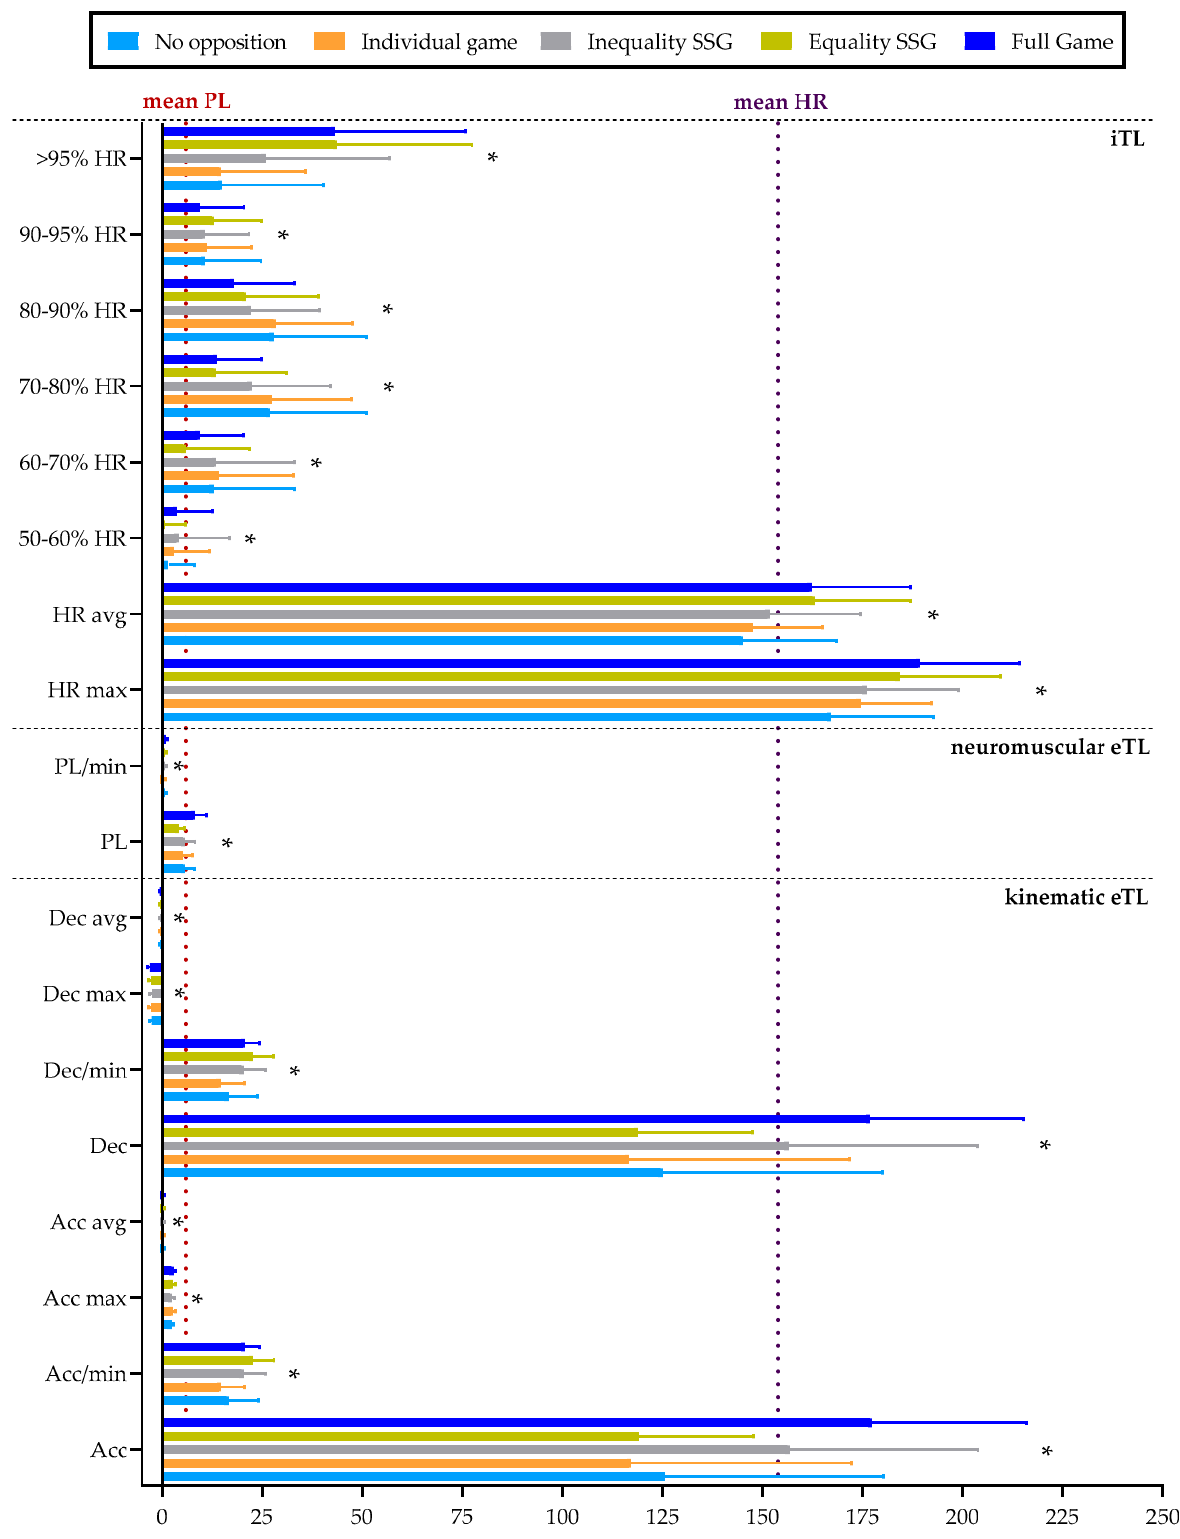
Figure 5. Descriptive results of the variables studied independently according to the game situation. Note: eTL = external load; Acc = acceleration; Dec = deceleration; PL = Player Load; iTL = internal load; HR = Heart Rate; min = minute; max = maximum; avg = average; SSG = Small-Sided Game. * p < 0.05.